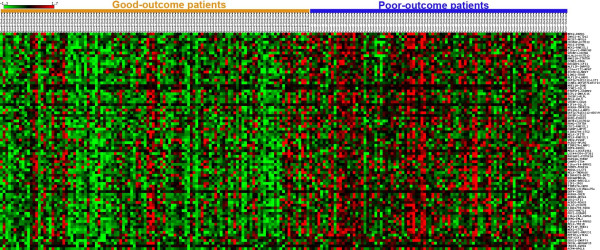
The heat map of the 80 signature gene pairs. The Wang data set is used to illustrate the gene expression values of the signature genes. A heat map is generated using the matrix2png software [34]. There are 80 rows corresponding to the 80 gene pairs; the displayed intensities are the differences between the expression values of the two genes in each pair. The expression value for each difference is normalized across the samples to zero mean and one standard deviation (SD) for visualization purposes. Differences with expression levels greater than the mean are colored in red and those below the mean are colored in green. The scale indicates the number of SDs above or below the mean.